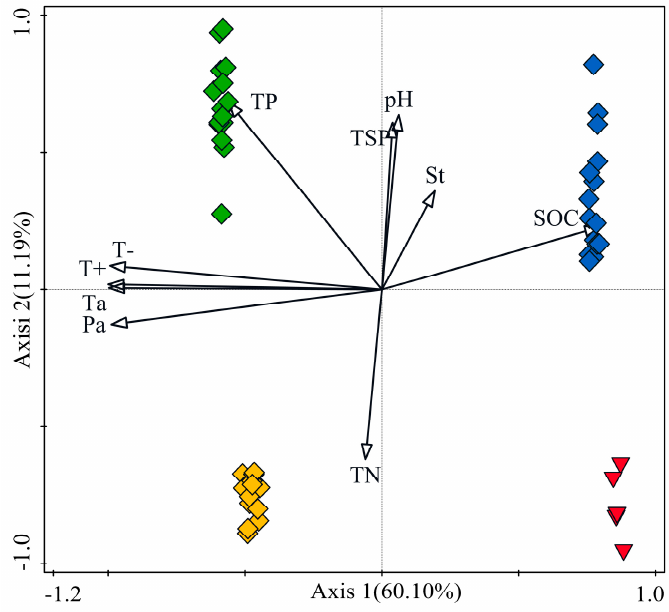
Figure 8. EM fungal community dissimilarity in each P. sylvestris stand across three sandy lands was tested by redundancy analysis (RDA). Red triangles represent NF (natural forest), blue diamonds represent HB (the Hulunbuir Sandy Land), green diamonds represent MU (the Mu Us Sandy Land), and yellow diamonds represent HQ (the Horqin Sandy Land). Arrows represent environment variables.